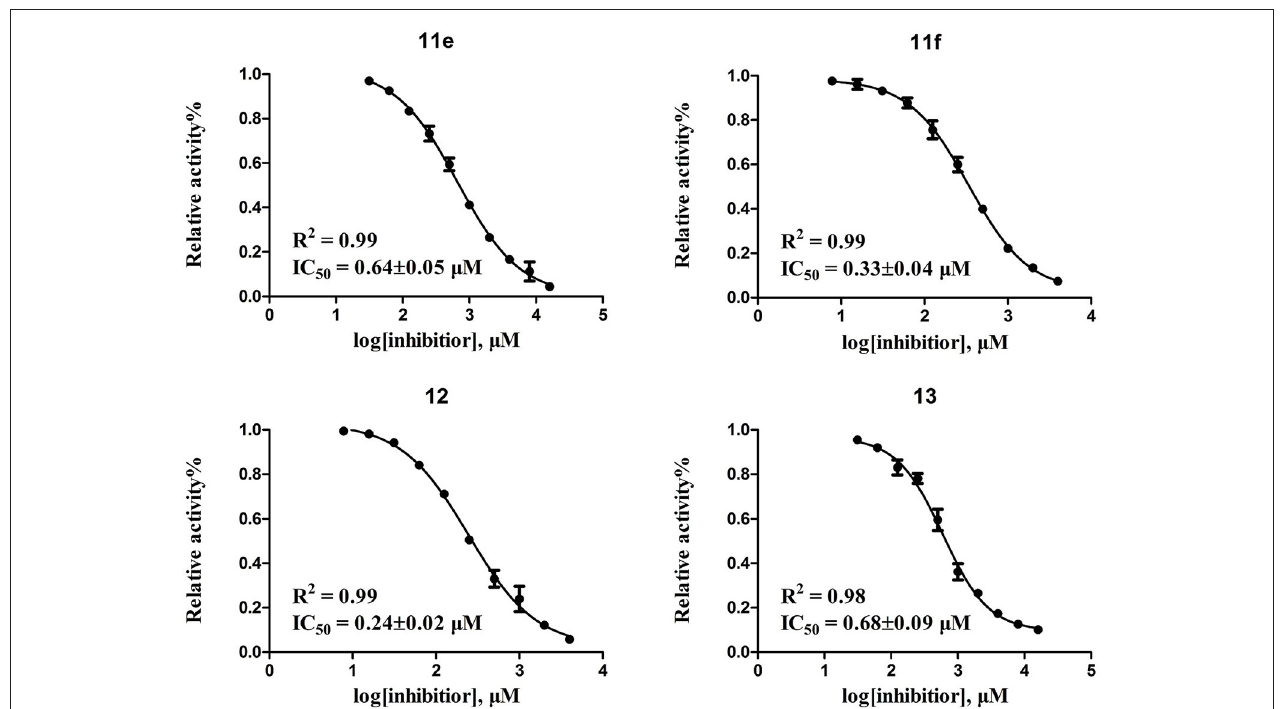
FIGURE 2 | Inhibitory curves of four of the most potent compounds toward